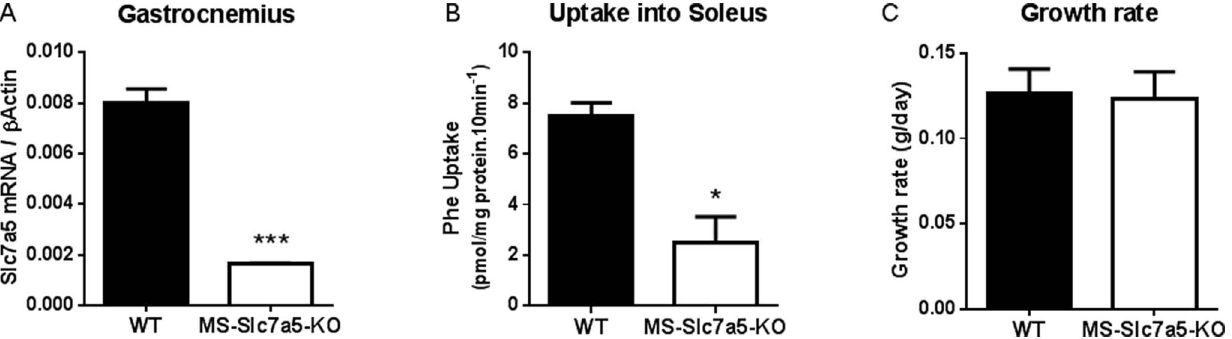
Figure 3. Slc7a5 gene expression and SLC7A5 transport activity in MS- Slc7a5 -KO mouse muscles and impact on tissue growth. (A) Reduced expression of Slc7a5 mRNA in MS- Slc7a5 -KO mouse gastrocnemius muscle (n=24) compared to wild-type (n=36). ***indicates p , 0.001 by unpaired t-test. (B) Reduced SLC7A5 (System L1) transport function (measured as Phe uptake) in MS- Slc7a5 -KO soleus muscle (n=4) compared to wild-type (n=6) *indicates p , 0.05 by unpaired t-test. (C) No difference on the growth rate of MS- Slc7a5 -KO and wild-type mice on standard chow diet (14% protein) (n=5).